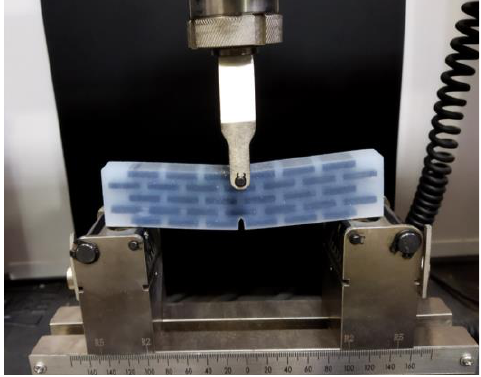
Figure 18. Three-point bending experiment of bionic layered